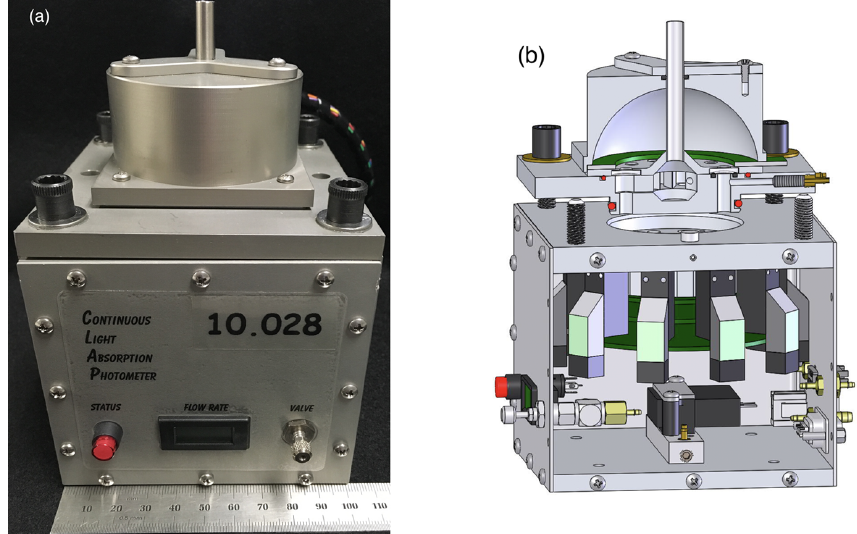
Figure 1. (a) Photograph of CLAP and (b) cross-sectional view of flow and optical paths in upper section and three-dimensional view of CLAP internal configuration in lower section. Scale on ruler on left image is in millimeters. An annotated version of (b) is included in the Supplement (Fig. S1).